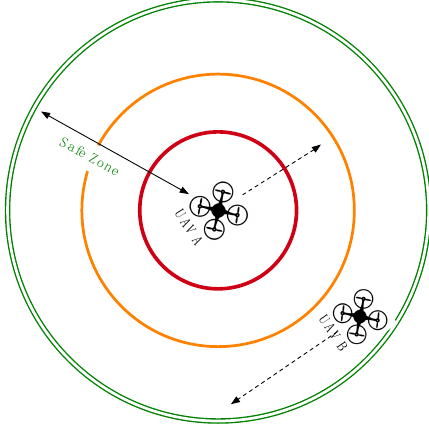
Figure 2. Case 1: closely monitor UAV B in the safe zone.